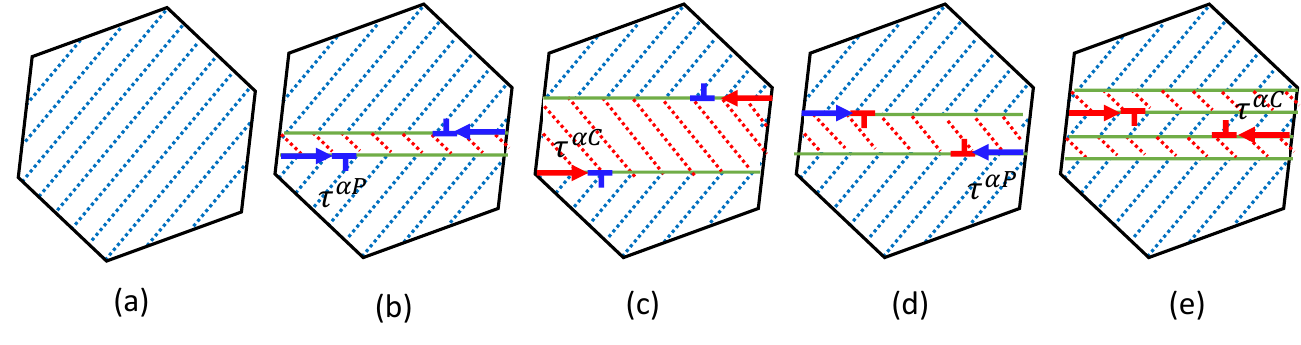
Figure 9. A schematic representing Twinning Detwinning (TDT) model within a grain, ( a ) pristine grain, ( b ) nucleation of a twin (child) grain with mirrored symmetry with the parent grain, ( c ) propagation of twin into the parent grain, ( d ) propagation of the parent grain into the twin/child grain, ( e ) activation of twinning dislocation inside twinned region, reproduced from [11], with permission from Elsevier